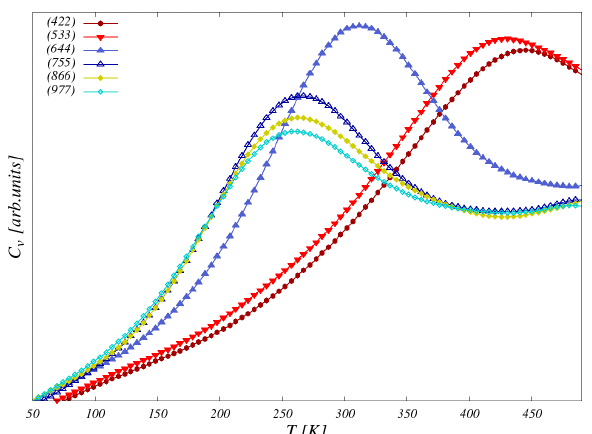
Figure 5. Heat capacity of the Fe nanowires for the magnetic anisotropy energy (MAE) of 4.76 meV.